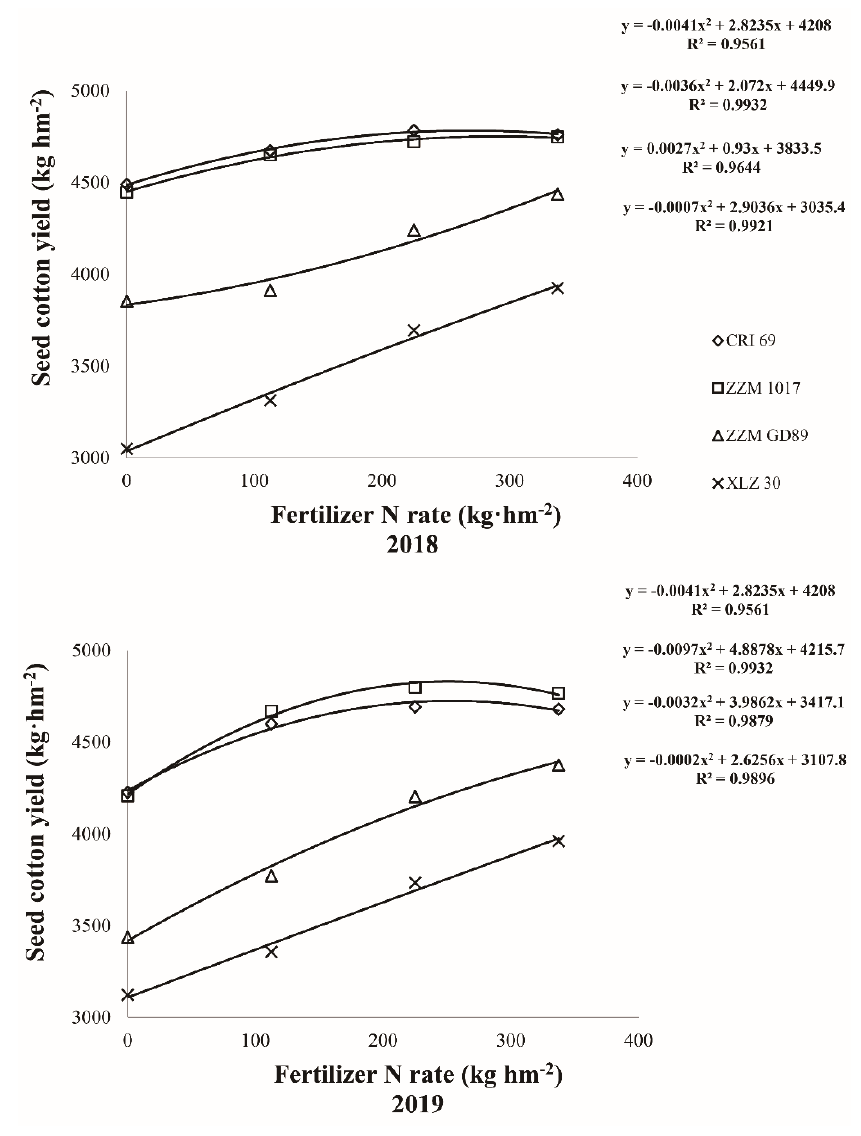
Figure 2. Mathematical model between N level and yield. Table 4. N utilization-related traits of cotton cultivars under different N-supply conditions in 2018 and 2019 Treatment